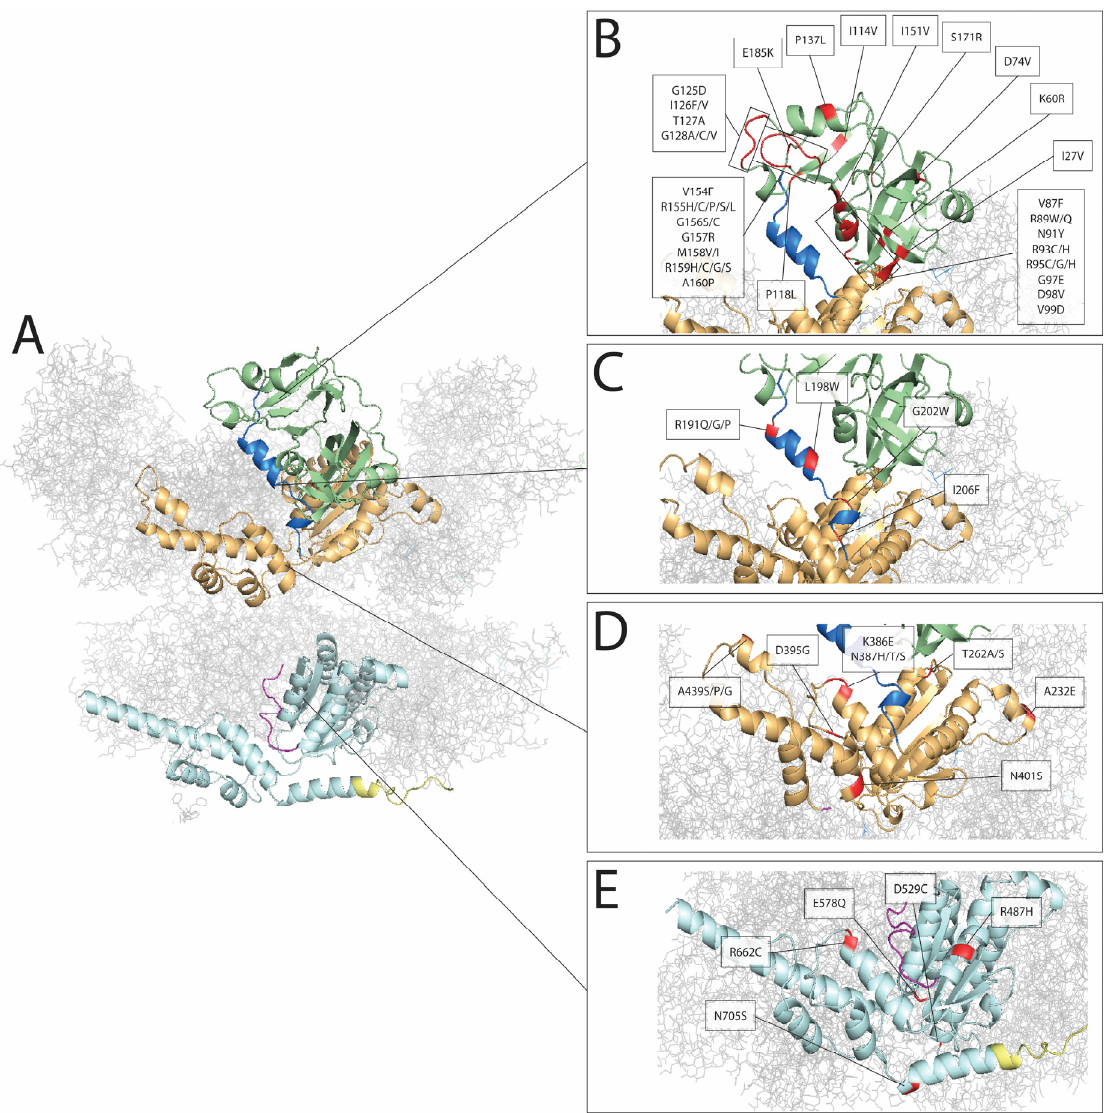
Figure 1. Pathogenic mutations represented on the 3D model of VCP. ( A ) Three-dimensional repre- sentation of the VCP hexamer. We have color-coded individual domains from a single VCP monomer for ease of reference in subsequent images: Green for the N-terminal domain, blue for the N-D1 linker, yellow for the D1 domain, purple for the D1-D2 linker, light blue for the D2 domain, yellow for the C-terminal domain, with grey lines representing the other 5 structural oligomers. In red, we have represented the locations of pathogenic variants in VCP, showing the positions in the N-terminal domain ( B ), linker domain ( C ), D1 domain ( D ), and D2 domain ( E ). This figure was generated using open source material available from Swiss model [108] and PyMOL [109] based on the proposed structure of the VCP hexamer